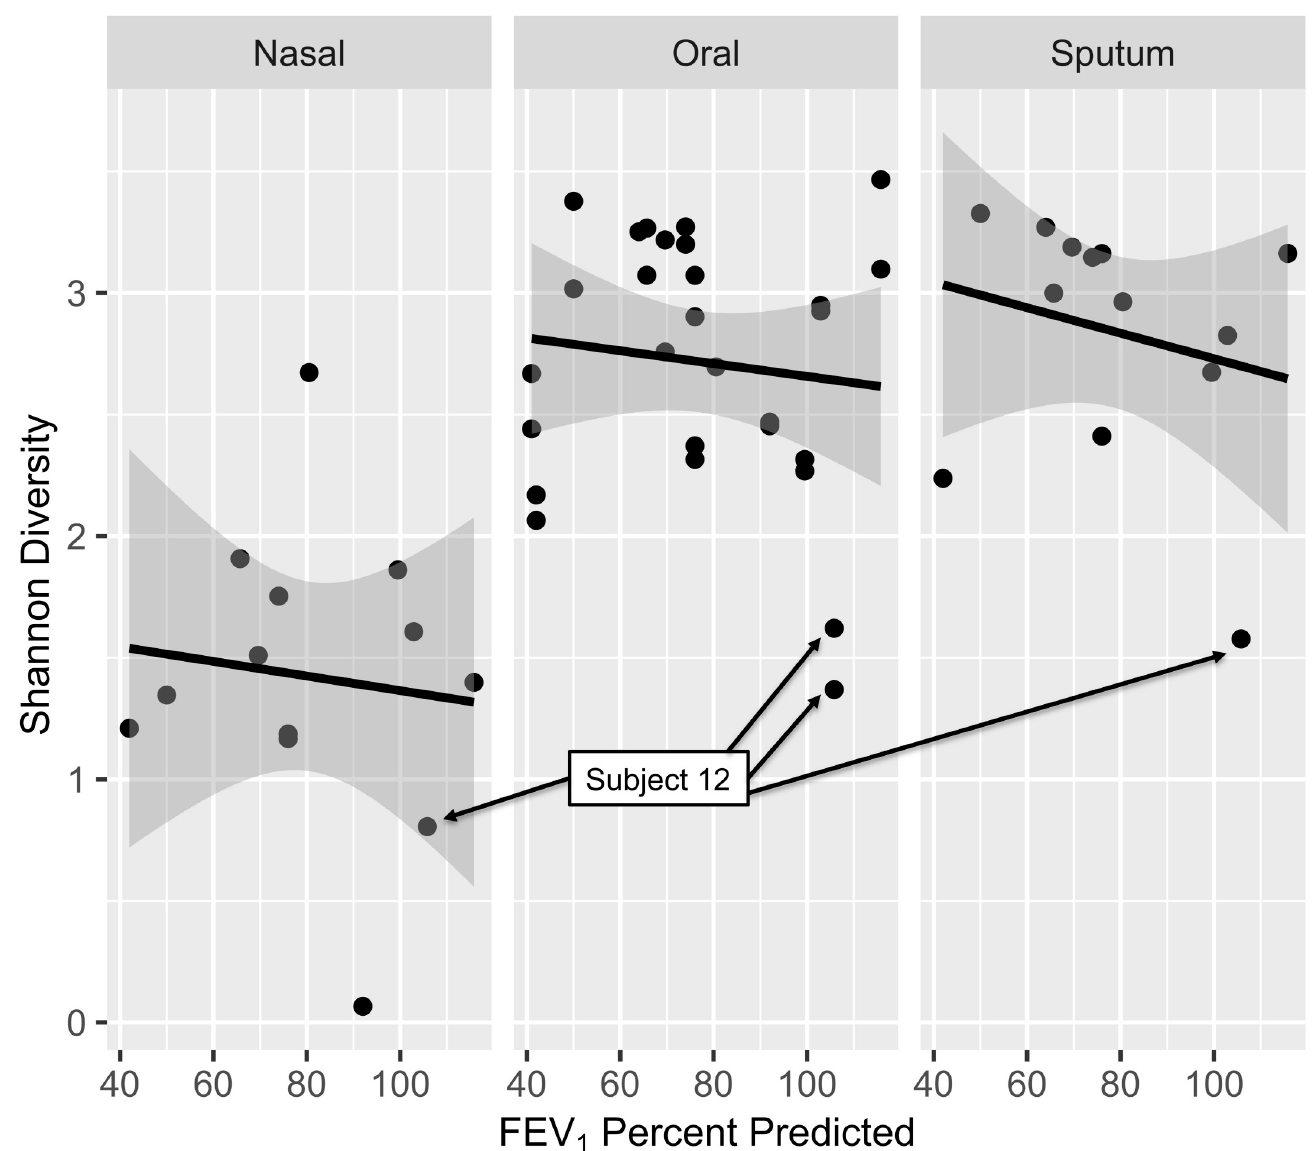
Fig 4. Low alpha diversity is consistently seen for one subject. Shannon diversity by anatomic site and FEV1pp is presented here with black lines illustrating predicted Shannon diversity at each site based on FEV1pp. Gray shading indicates the 95% confidence interval for the regression line. Although FEV1pp was not a significant predictor of alpha diversity in our dataset, we noted that all four samples from one subject (12, labeled above) exhibited very low diversity, particularly at the oral and sputum sites. This subject was unique in our dataset in that she was the only woman and had three independent lung